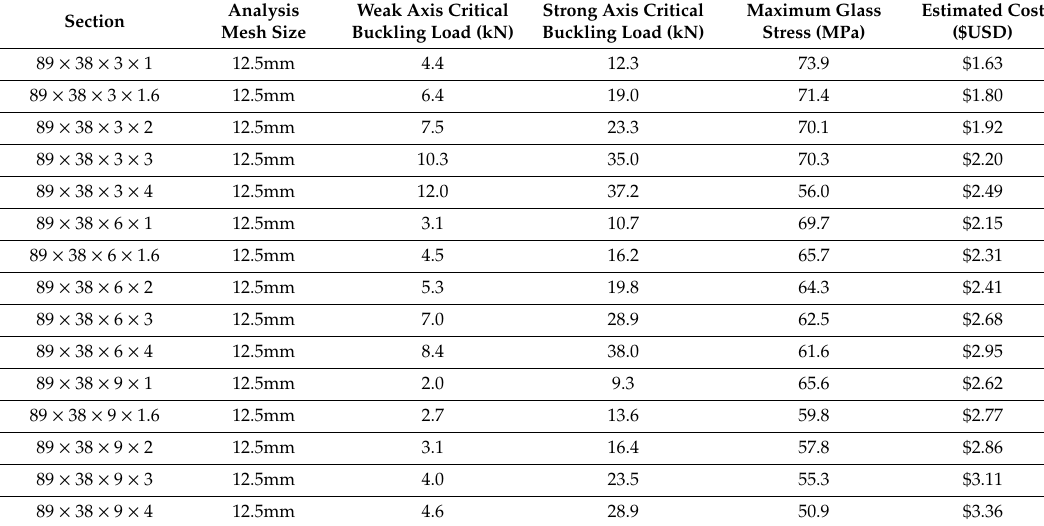
Table 2. The resulting weak and strong axis buckling loads of the GRCCs targeting a substitution for standard 2 × 4 stud timber framing.